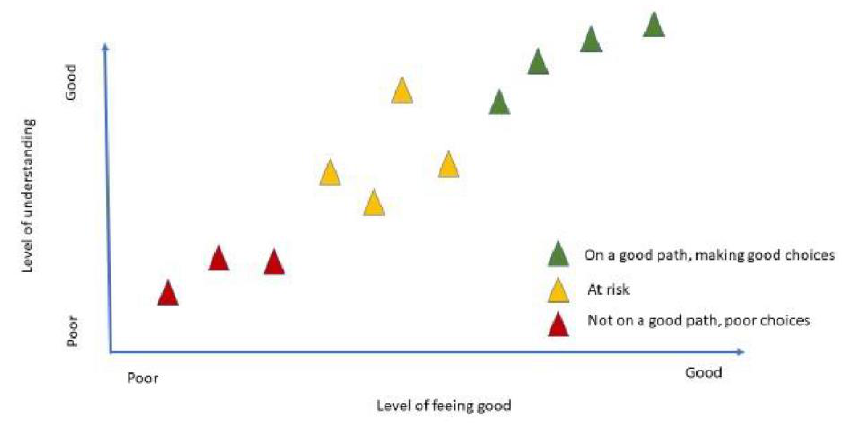
Figure 2. Good feelings based on clear understanding led to good choices.